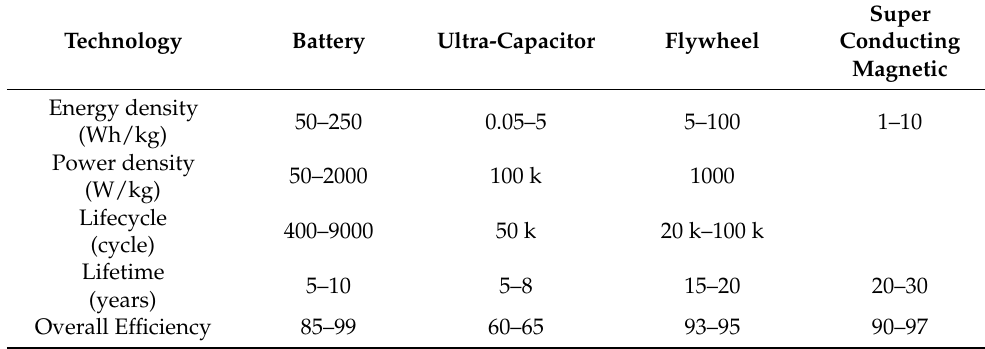
Table 4. Energy storage system comparison [16].